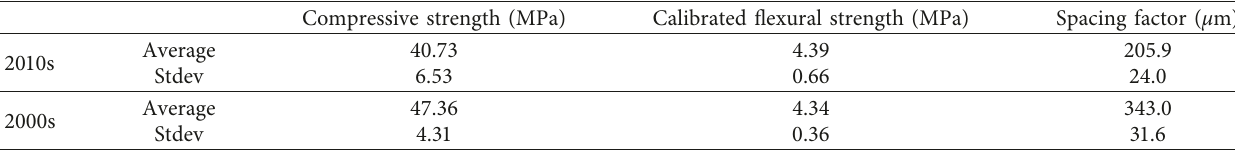
Figure 3: Pavement condition according to maximum distresses occurrence year. (a) HPCI Table 7: Test result of concrete properties using in situ core specimens.